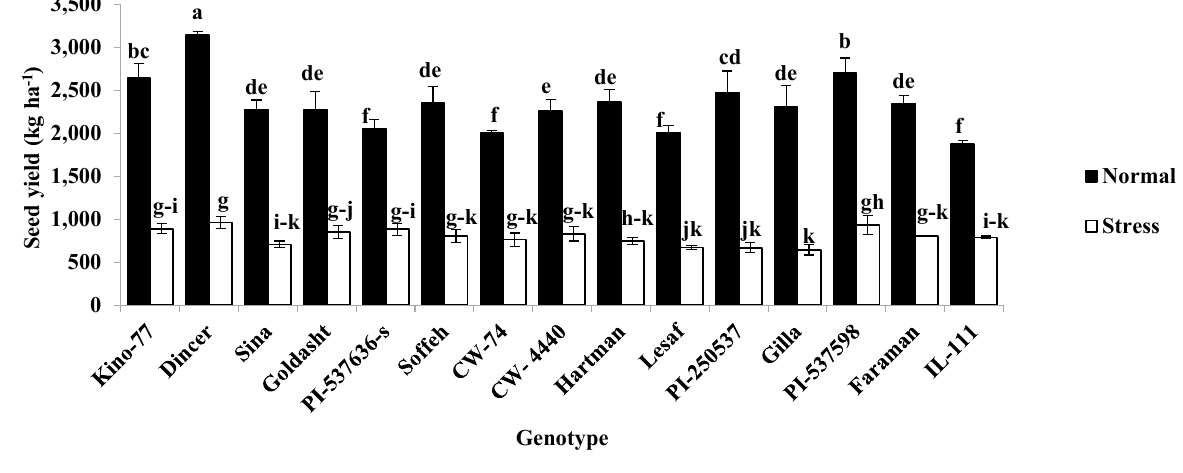
Fig. 3 Interaction effect of irrigation and genotype on seed yield. Mean values with the same letters are not significantly different ( p > 0.05) according to the Duncan test. Data are presented as mean ± SEM .